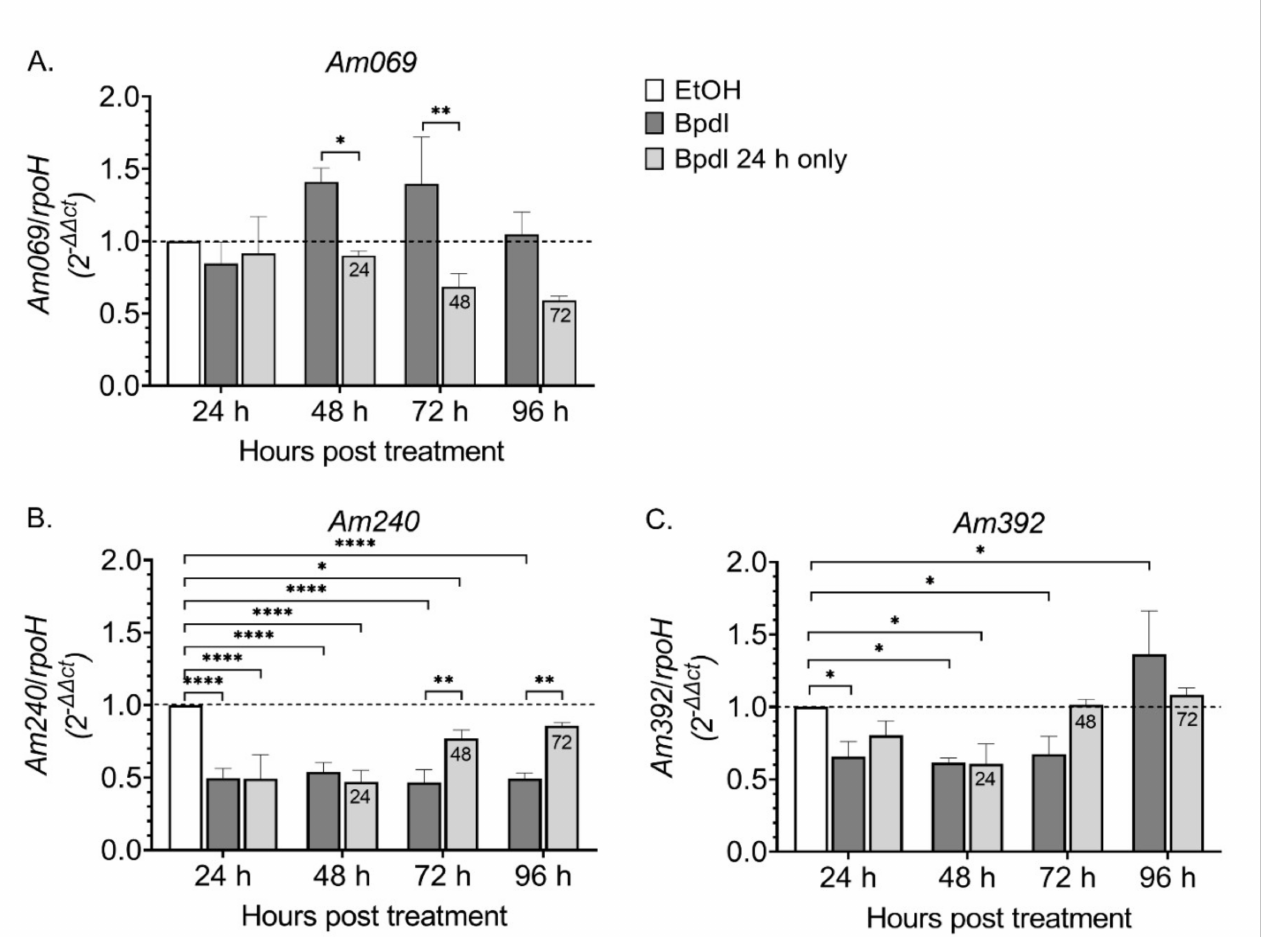
Figure 7. Transcriptional response of Am069 ( A ), Am240 ( B ), and Am392 ( C ) to iron reduction and restoration. All cells were infected with A. marginale 24 h prior to the start of the experiment. Cells were treated with the carrier (EtOH), the chelator (Bpdl), or with the chelator for only 24 h (Bpdl 24 h only). The x-axis indicates time post-treatment in hours. The numbers in the light grey bars (Bpdl 24 h only) indicate the amount of time following iron restoration. The y-axis is the relative normalized expression (2 − ∆∆ Ct ) of the ratio of the abundance of Am069 , Am240 , or Am392 transcript in Bpdl treated cells or cells treated with Bpdl for only 24 h to carrier-treated cells normalized to expression of rpoH under the same conditions. Error bars indicate SEM of four independent replicates for the iron depletion experiments and three independent replicates for the iron restoration